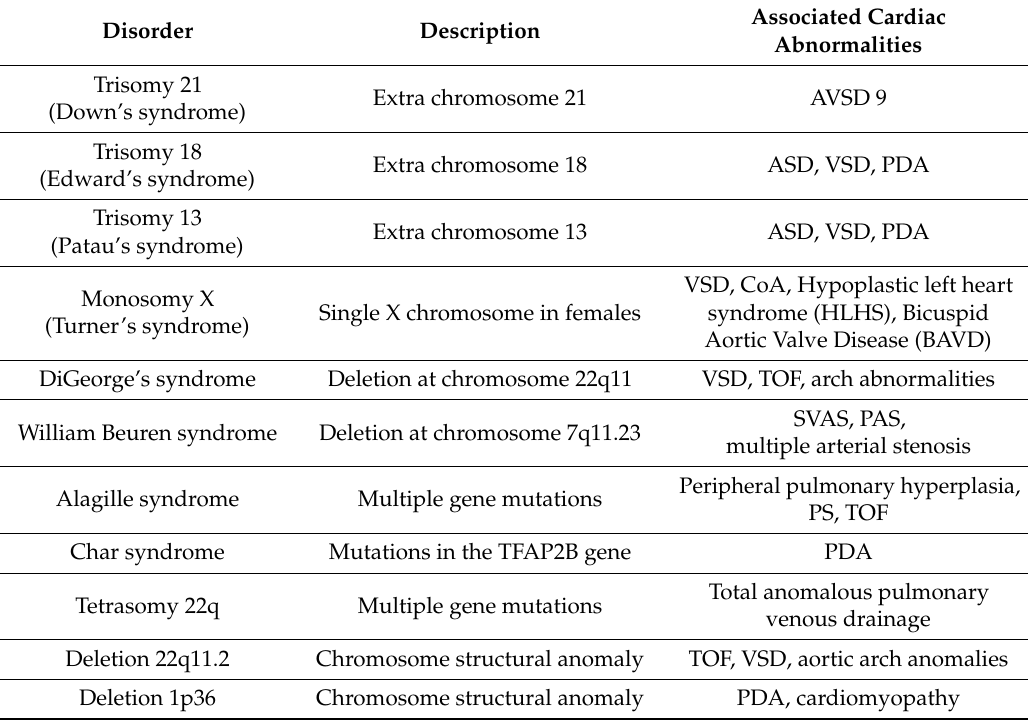
Table 1. Chromosomal disorders that cause congenital heart